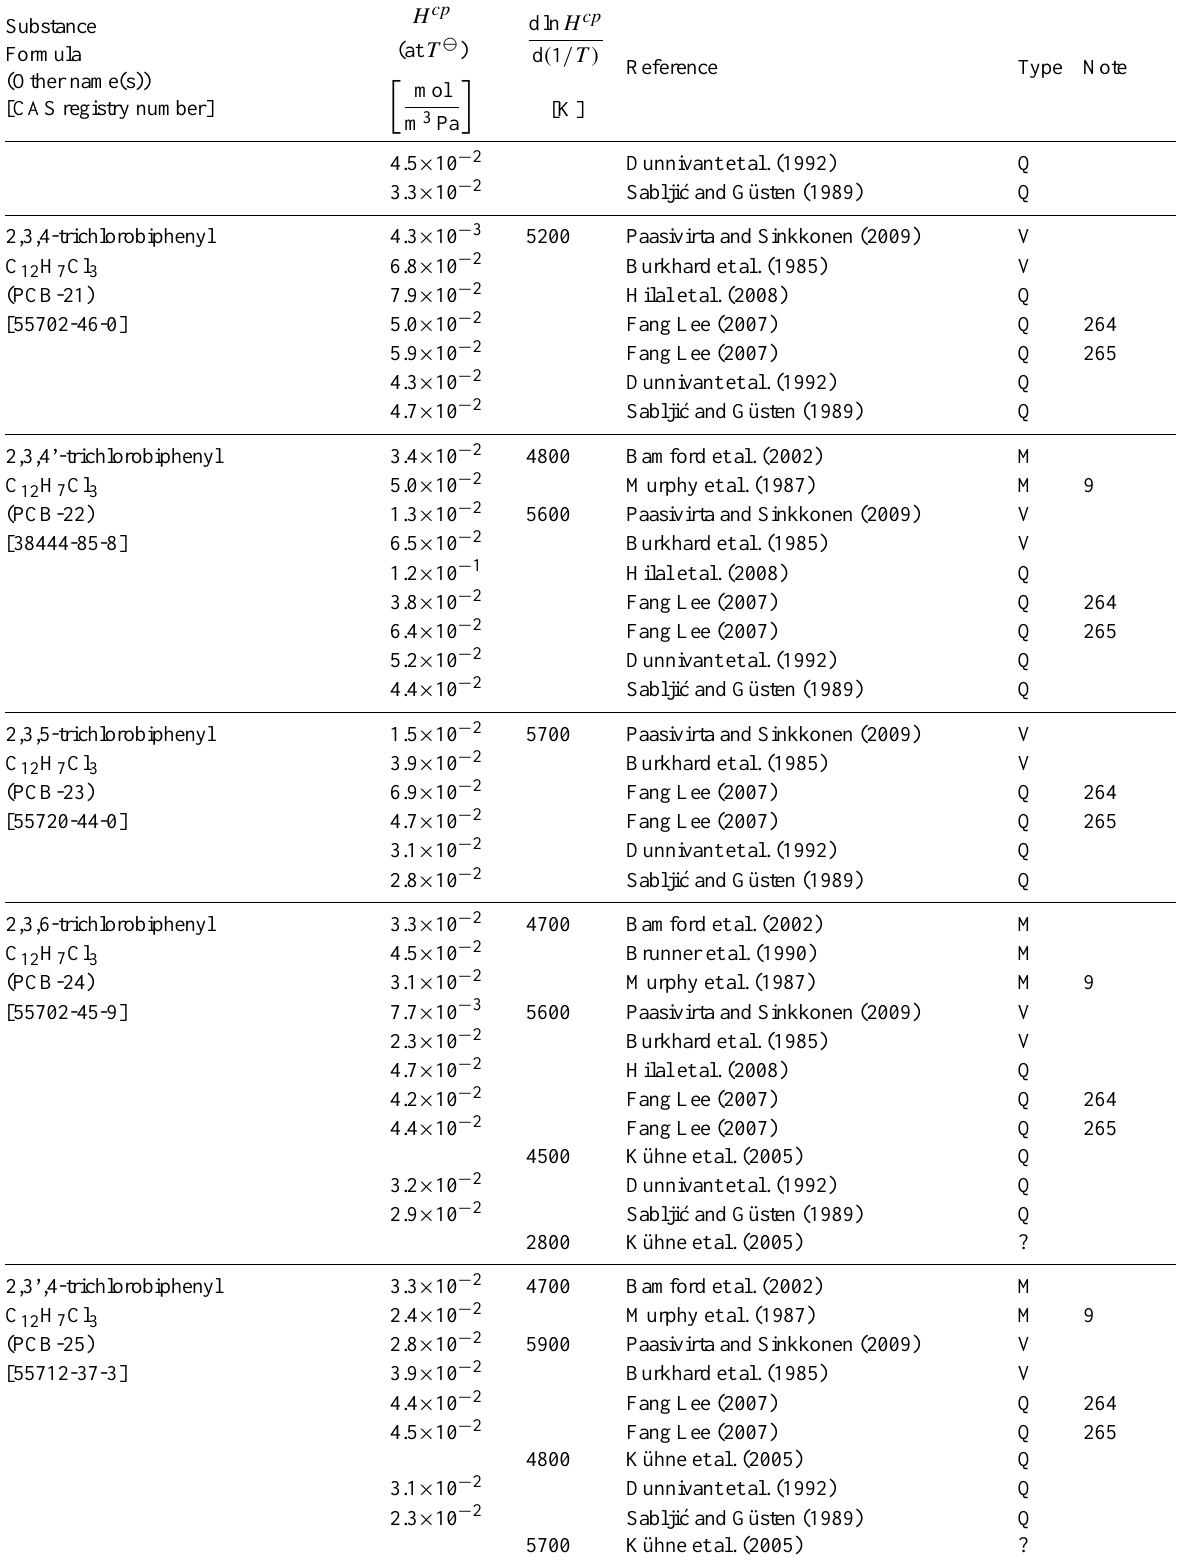
Table 6: Henry’s law constants for water as solvent